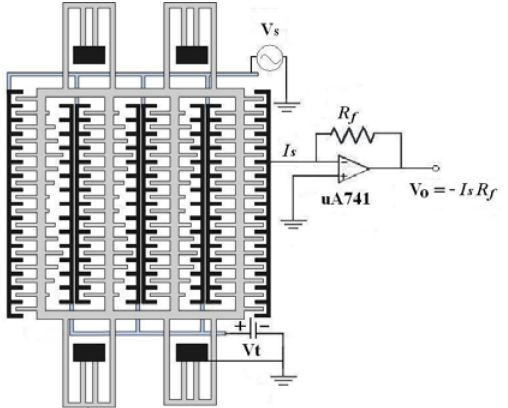
Figure 12. Sensing circuitry of the